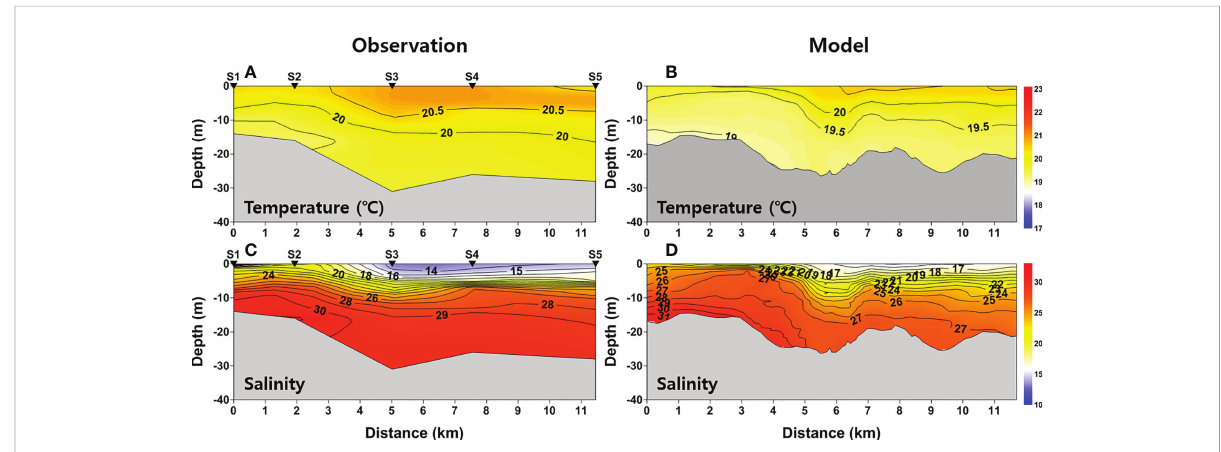
FIGURE 3 Comparison of (A) and (C) observed and (B) and (D) modeled vertical pro fi les from stations S1 to S5 for (A) and (B) temperature and (C) and (D) salinity on 13 July 2003.